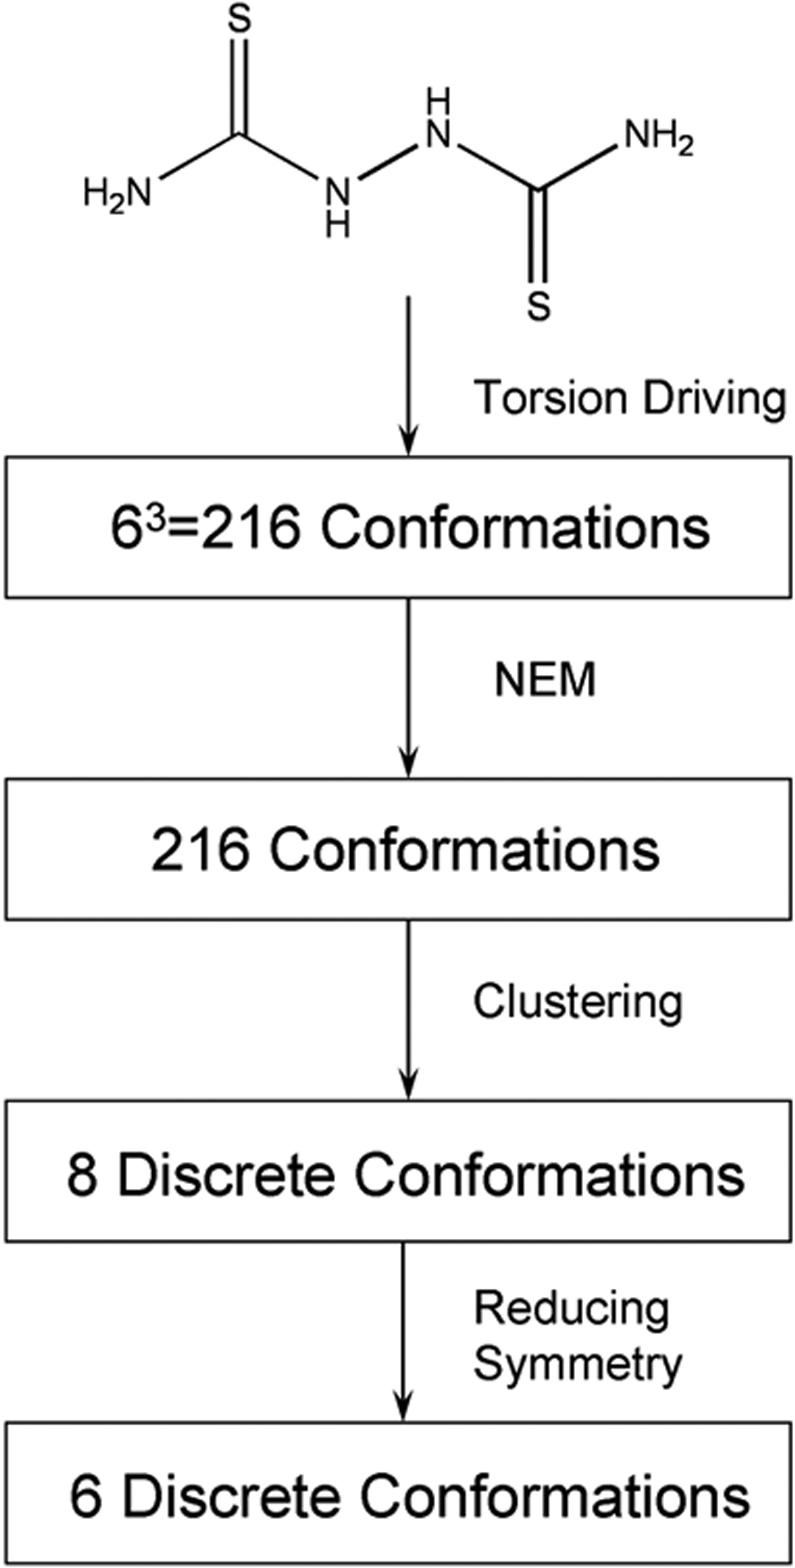
Process for generating the six different local minimum conformations of dithiobiurea used in a docking study to reproduce the dithiobiurea–18-crown-6 crystal structure.